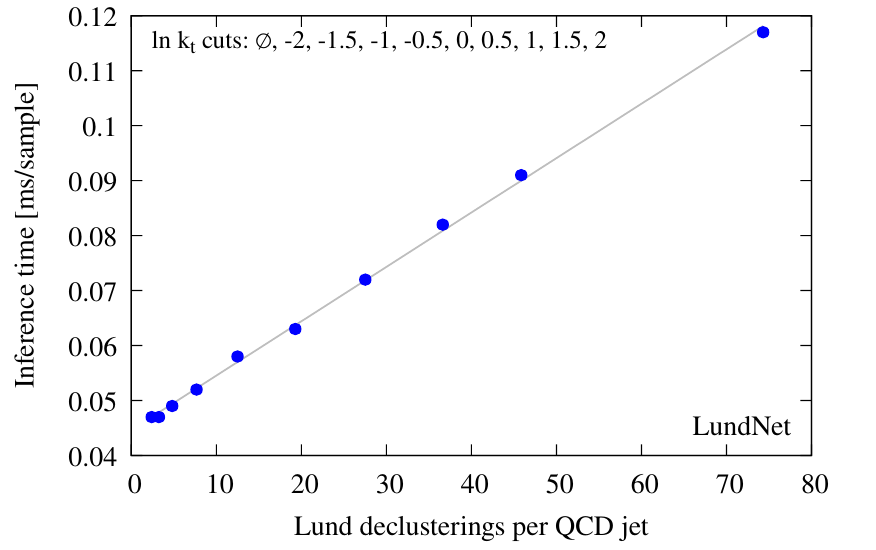
Figure 12 . Inference time per jet of the LundNet model as a function of the mean number of Lund declusterings per 2 TeV QCD jet. Each circle corresponds to a separate LundNet model trained for a different k cut, as indicated in the figure t